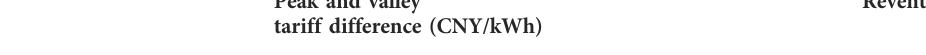
TABLE 2 Comparison of pro fi t of PSPP under different